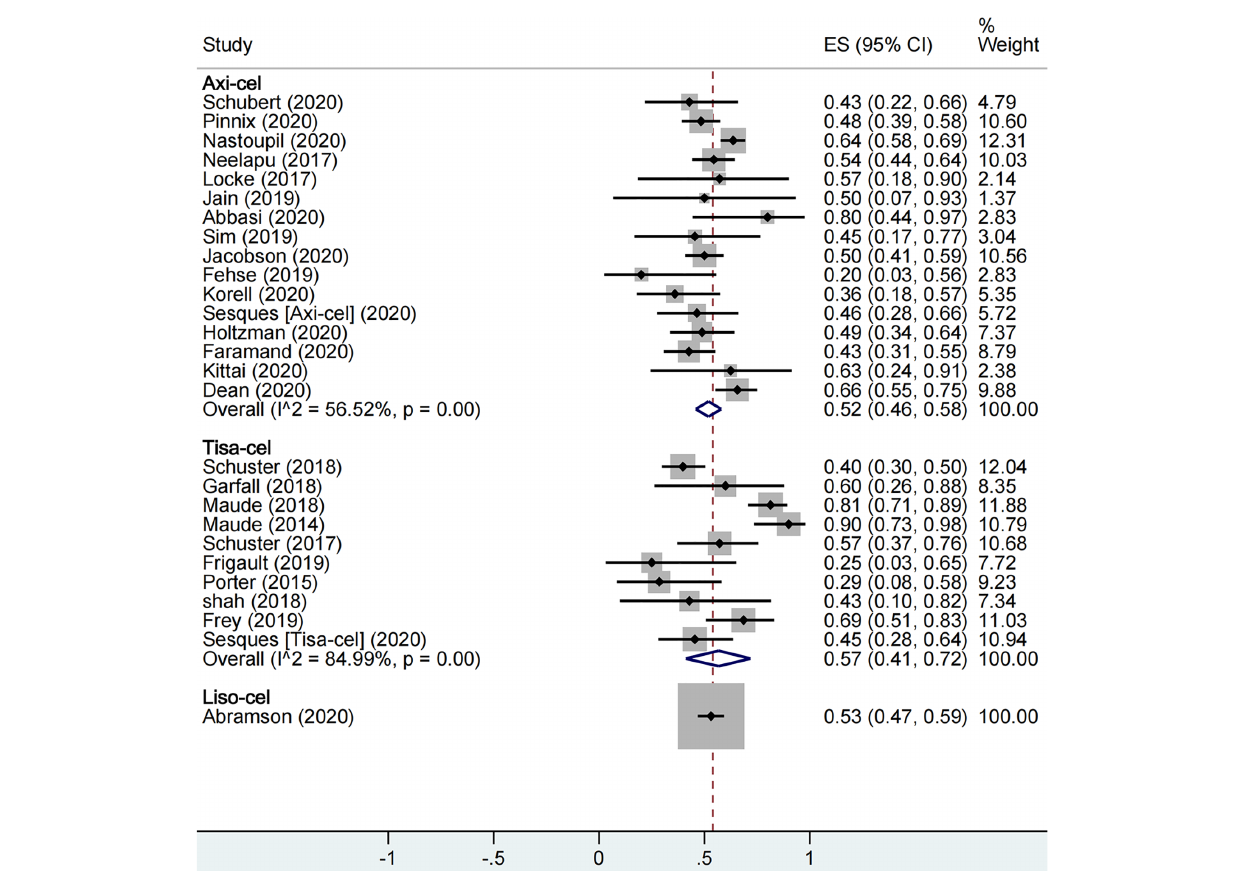
( Figure 7B ). The study on liso-cel included three patients with grade 3B FL, two patients among them achieved CR and report the safety events.